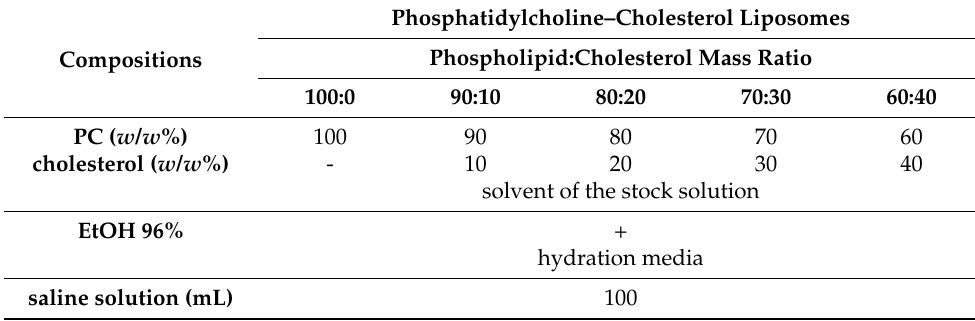
Table 1. Phosphatidylcholine and cholesterol-based (PC-CH) compositions.